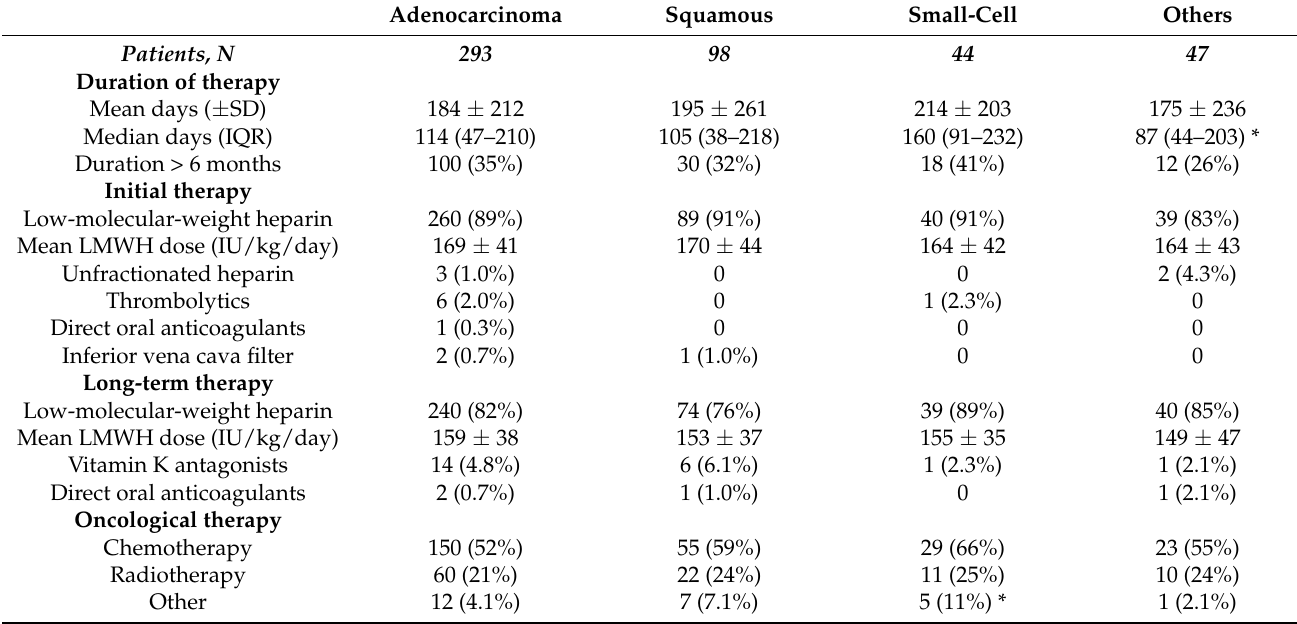
Table 2. Treatment strategies according to the histology. Adenocarcinoma Squamous